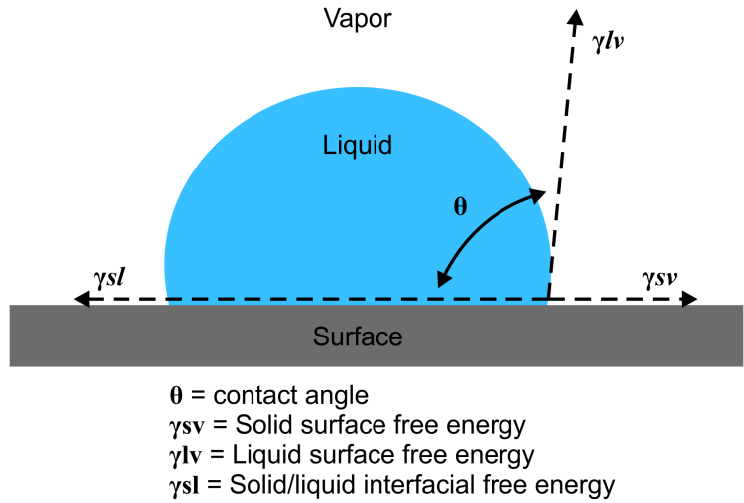
Figure 2. Schematic representation of Young’s equation. Table 1. Surface tension, and polar and dispersive components of liquids. Adapted with permission from [20]. Copyright 2022. American Chemical Society .